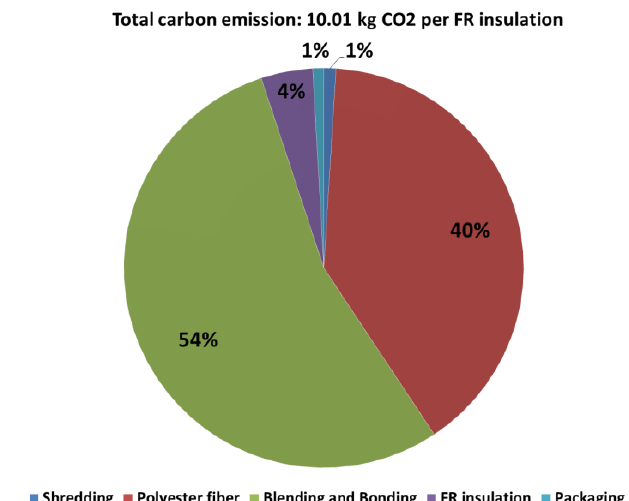
Figure 7. The percentage breakdown of carbon emissions by one kilogram of FR cotton/polyester